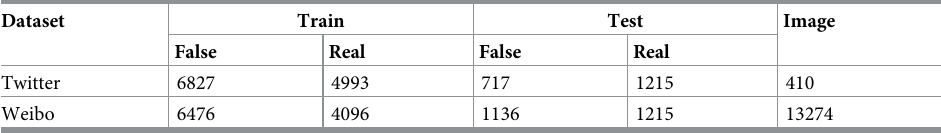
Table 1. Data distribution of the Weibo and Twitter datasets.